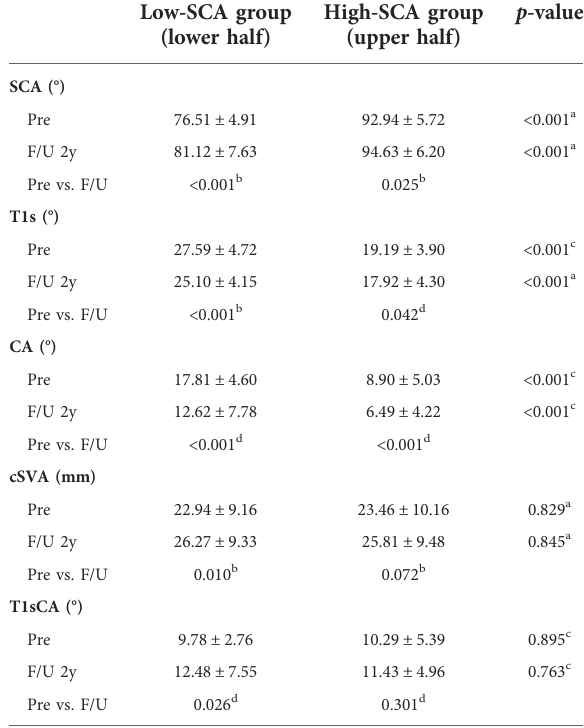
TABLE 2 Comparison of radiologic and clinical parameters according to preoperative SCA.